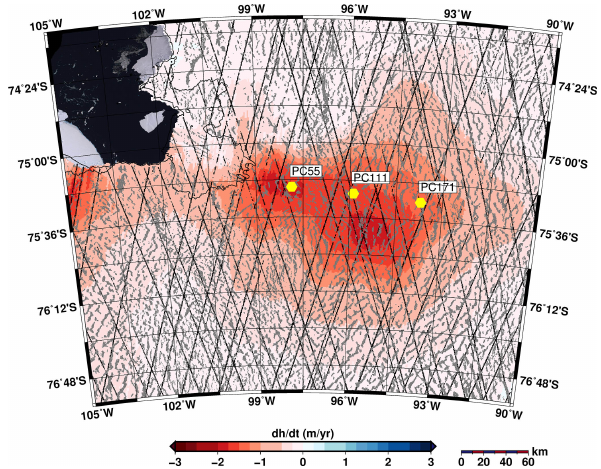
Figure 13. Elevation change occurring at the Pine Island Glacier in West Antarctica. Data coverage of d h /d t measurements are shown for CryoSat-2 (gray) and ICESat (black). The yellow hexagons rep- resent the GPS sites in Scott et al. (2009)